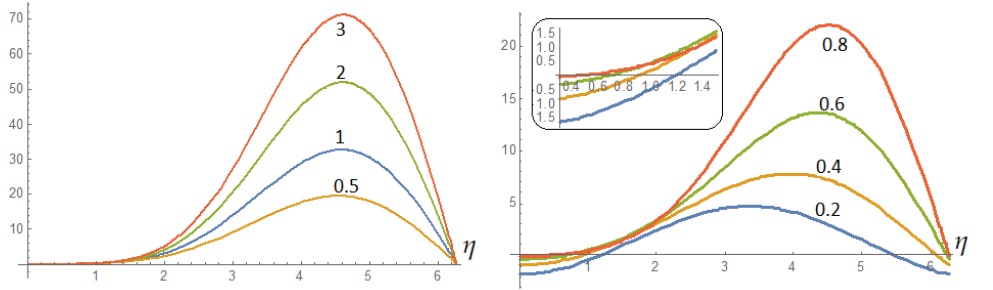
Figure 1. Time dependence of N ∗ = 2 N 2 − BN 1 . Left : ∆ = 1, B = 0.5,1,2,3; right : B = 1, ∆ = 0.2,0.4,0.6,0.8; for other values B and ∆ the plots looks similarly. The inset on the right panel clarifies the points where N ∗ = 0. Please note that ρ and d 2 r / dl 2 at R = R th are positive or negative simultaneously with N ∗